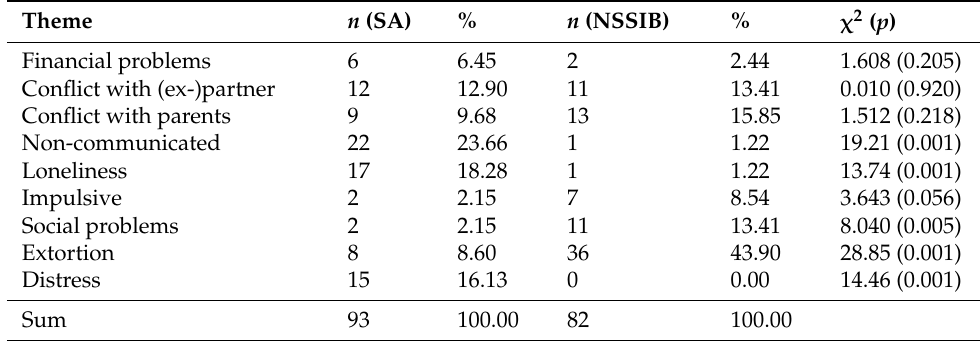
Table 2. Different themes in the justification of motives for suicidal behavior between patients engaged in suicide attempt (SA) and in non-suicidal self-injurious behavior (NSSIB) as revealed by qualitative data analysis of patients’ statements.